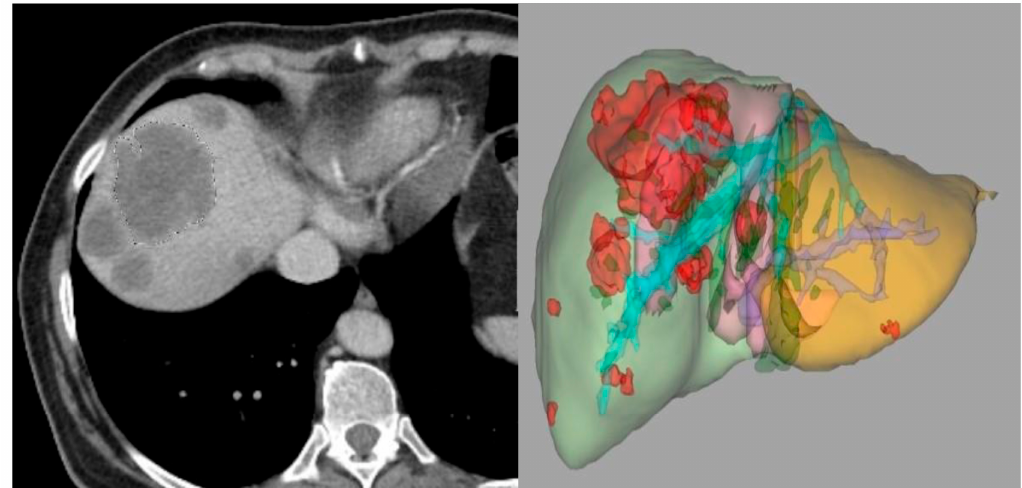
Figure 4. Three-dimensional semi-automatic segmentation of liver metastases of colorectal cancer.